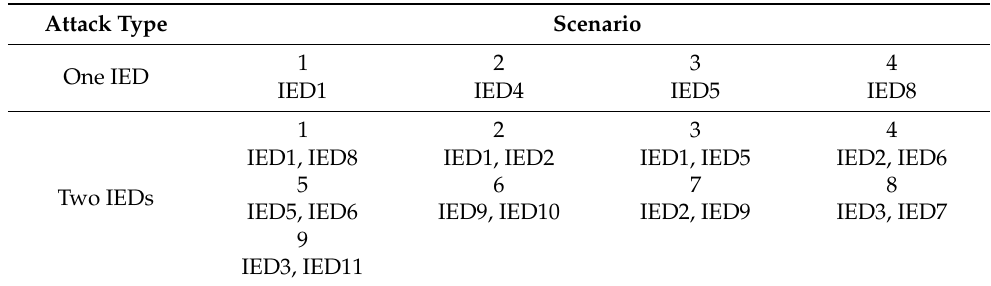
Table 4. Scenario division of cyberattack IED.